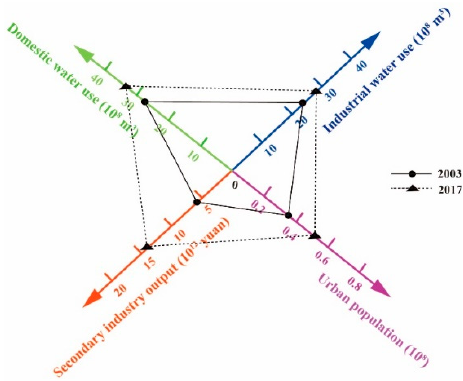
Figure 3. Indicators of water pollution and socio-economic development in Shandong from 2003 to 2017.